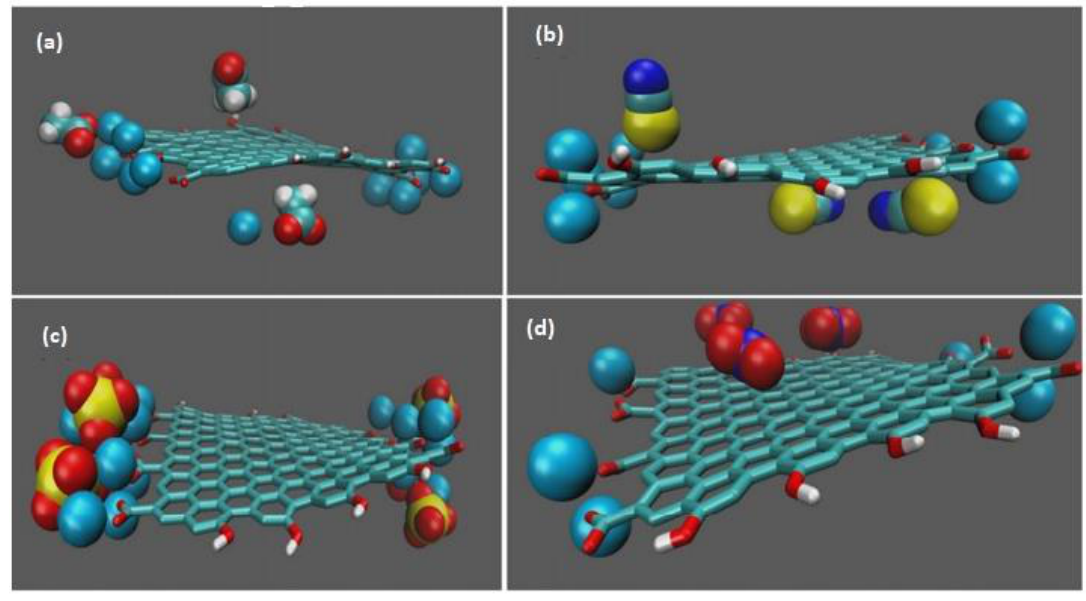
Figure 3. Visual molecular dynamics simulation of the attachment between graphene oxide (GO): ( a ) CH 3 COO − ; ( b ) SCN − ; ( c ) SO 42− and ( d ) NO 3− . * Color coding: C-cyan, O-red, N-dark blue, H-white, S-yellow, Na-light blue [82].